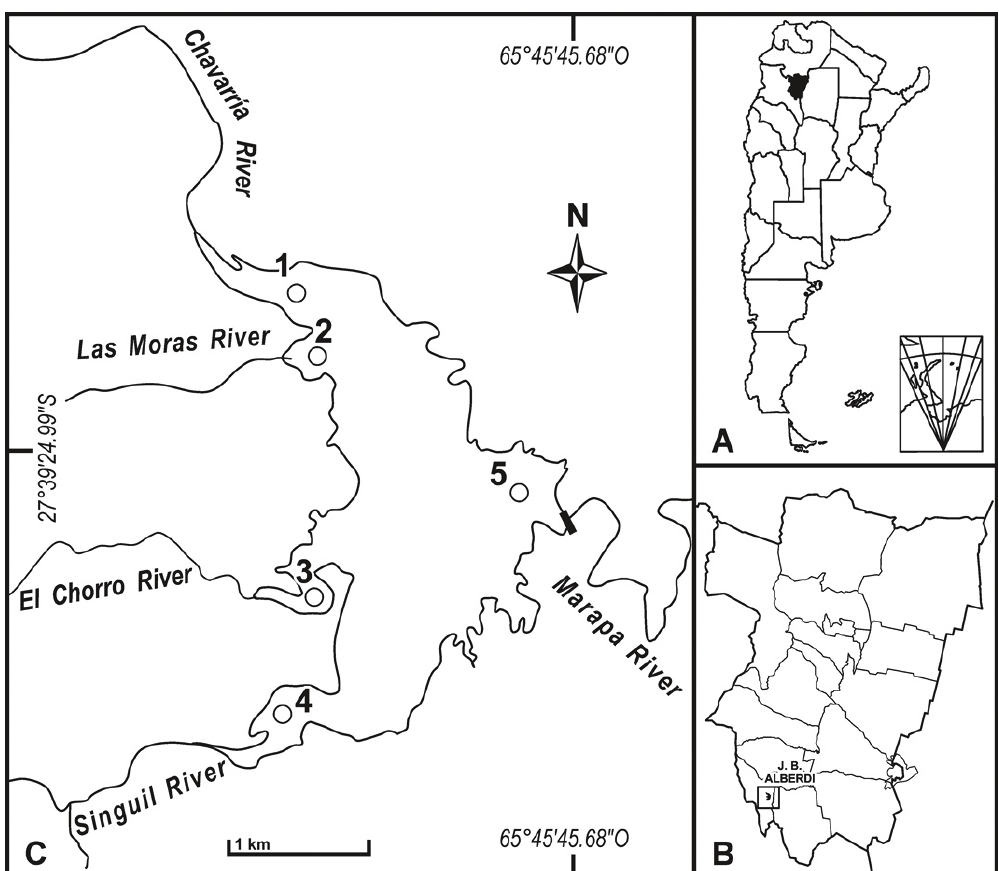
Figure 1. A- Location of Tucumán, Argentina. B- Escaba Reservoir in Tucumán. C- Study area and sampling sites: 1- Chavarría River; 2- Las Moras River; 3- El Chorro River; 4- Singuil River; 5- Escaba reservoir (limnetic